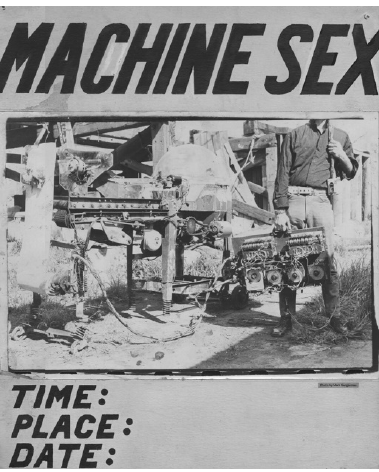
Figure 13. Poster for Machine Sex , a mechanical performance by Mark Pauline, February 1979, Chevron station, Columbus & Green, San Francisco. © Survival Research Labs.